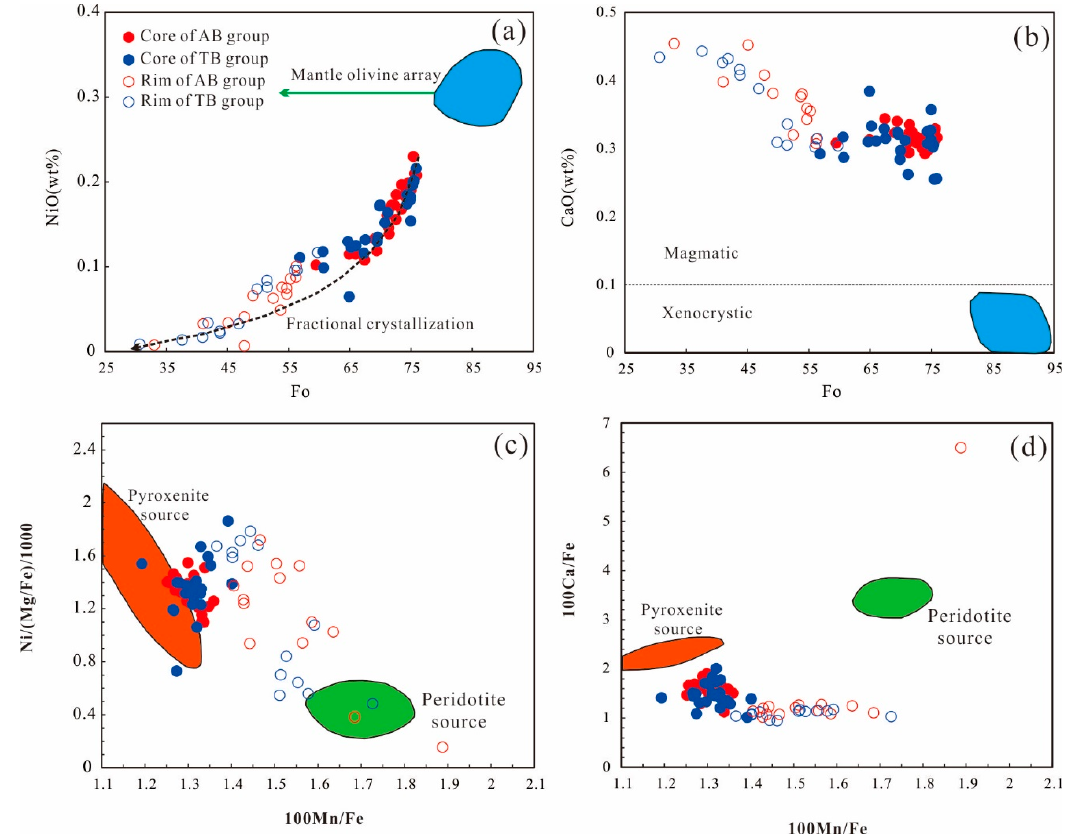
Figure 11. The composition variation of olivines from the Qianjaidian mafic rocks. ( a ) The mantle olivine array and fractional crystallization trend are from [65]. ( b ) The dashed line separates the composition of magmatic and xenocrystic olivine on the basis of CaO [66]. The fields and lines in plots ( c , d ) are from [67]. All plots concur in a dominant pyroxenite source for the Qianjaidian mafic rocks.